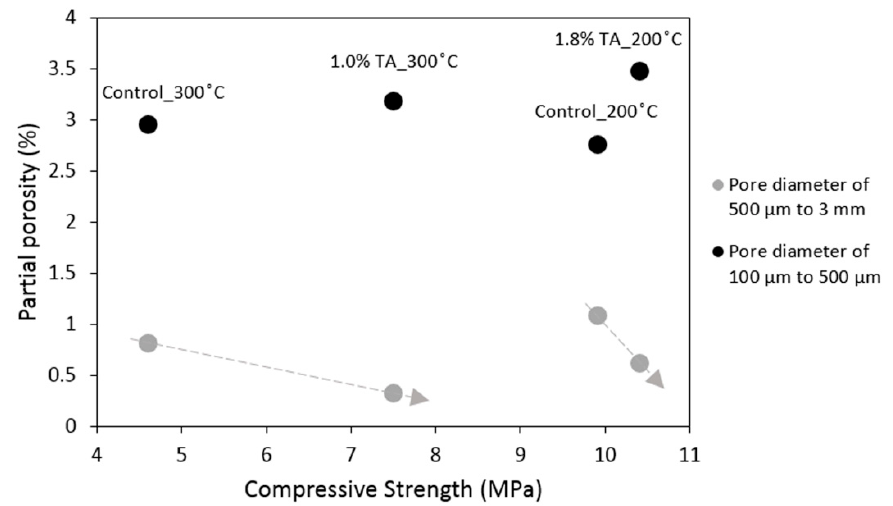
Figure 3. Compressive strength vs. calculated partial porosity for pores of small (100 µm to 500 µm) and large (500 µm to 3 mm) diameters in control and retarded TSRC specimens.